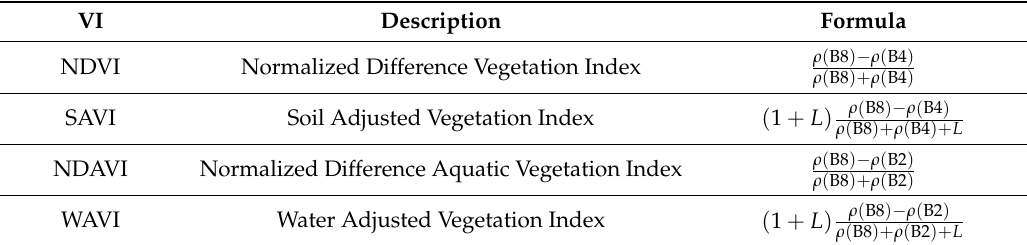
Table 2. The formulae of vegetation indices to be